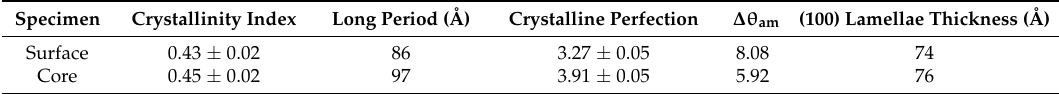
Table 2. Microstructure indexes deduced from wide-angle X-ray scattering (WAXS) experiments. Specimen Crystallinity Index Long Period